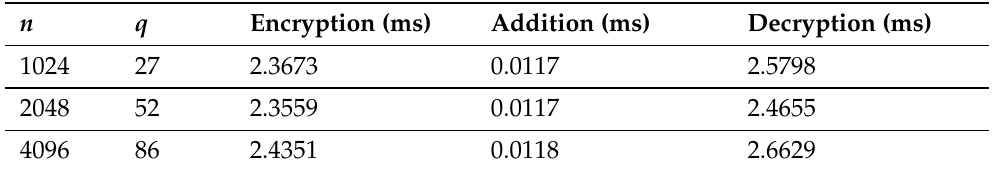
Table 6. Algorithm profiling: parameters n and q as the polynomial modulus degree and coefficient modulus, respectively, in a BFV encryption based on a previous study [36]. The steps of encryption, addition, and decryption are depicted in the